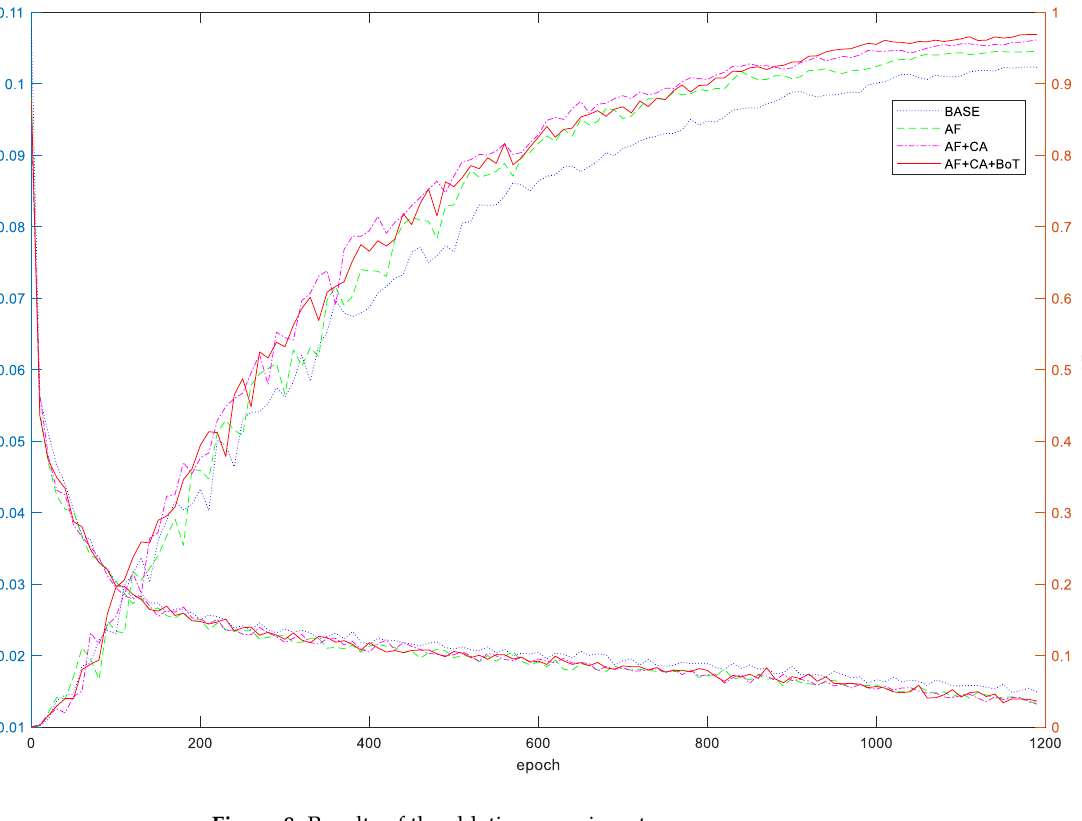
Table 2. Comparison table of experimental results. Model